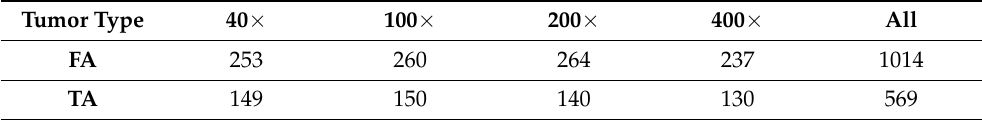
Table 1. Number of images at 40 × , 100 × , 200 × , and 400 × magnification factors from BreaKHis dataset stratified with respect to cancer subtype. FA: fibroadenoma, TA: tubular adenoma, PT: phyl- lodes tumor, AD: adenosis, DC: ductal carcinoma, LC: lobular carcinoma, MC: mucinous carcinoma, PC: papillary carcinoma, N: number of